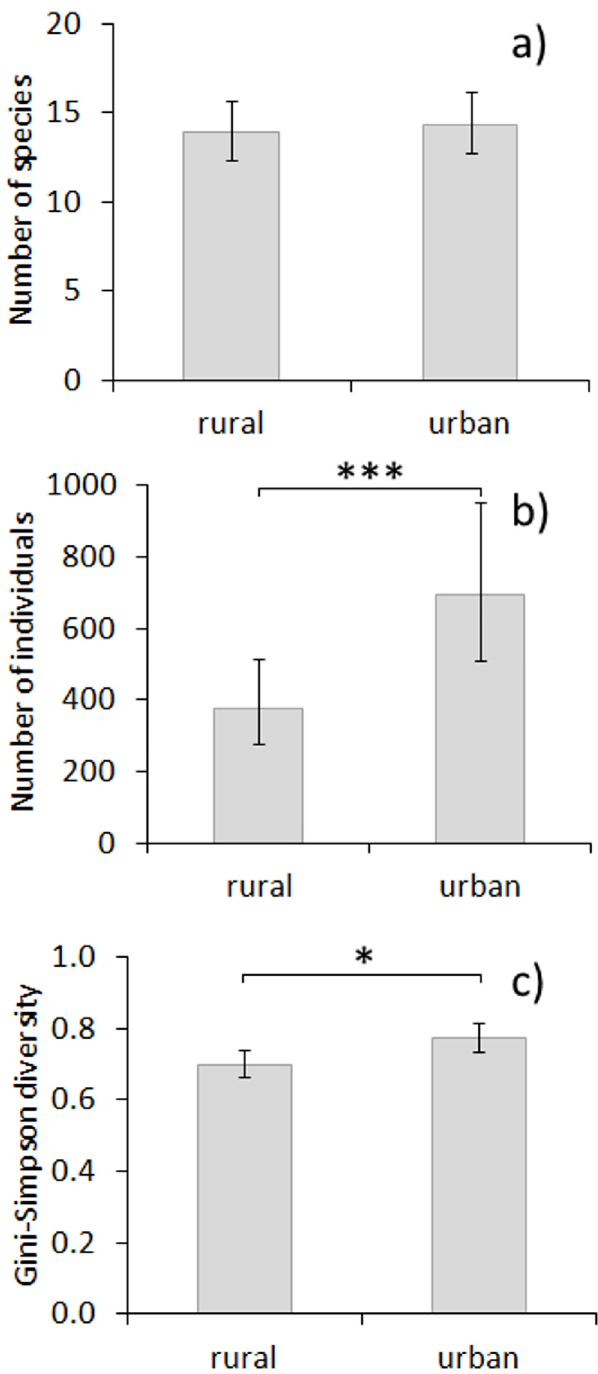
Fig 2. The effect of environment type on wintering birds. The effect of environment type on mean (a) species richness, (b) abundance and (c) species diversity of wintering birds. Whiskers are 95% confidence